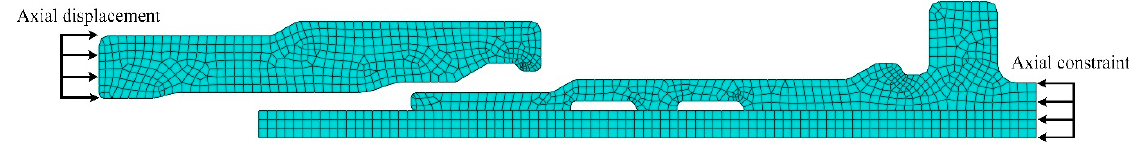
Figure 5. The extrusion-forming simulation of joint.